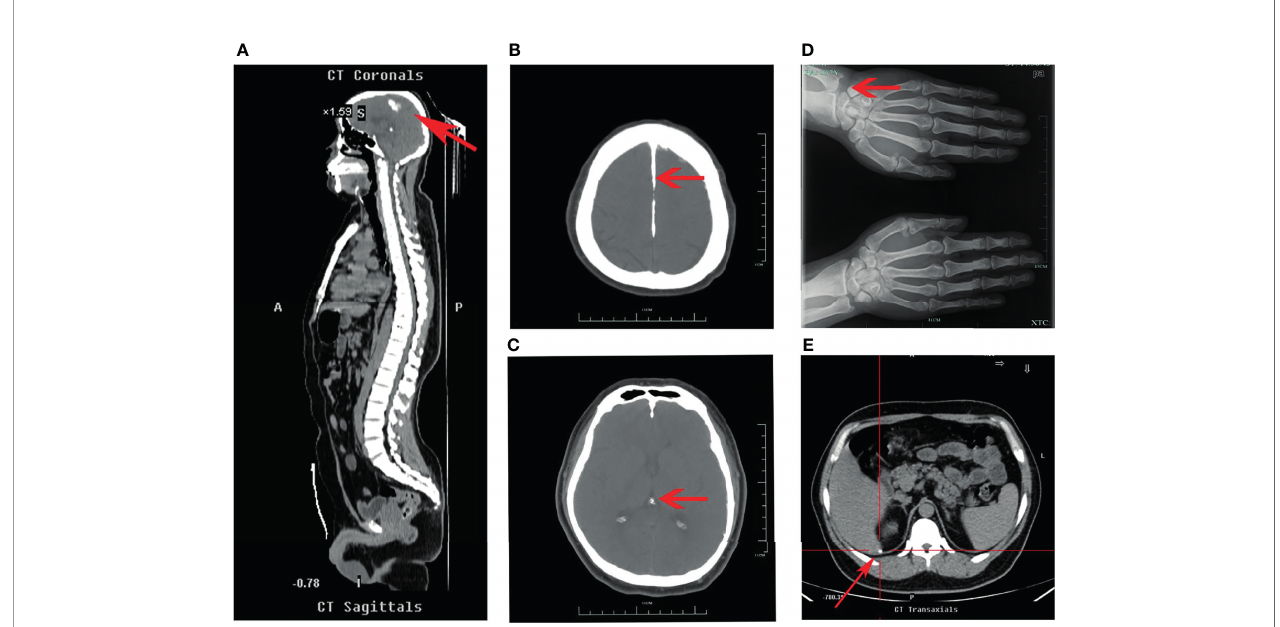
FIGURE 1 | Upper half of body CT, head CT, and X-ray images of the both hands of the patient. (A, B) Upper half of body CT and head CT scans, respectively. Red arrows both indicate calci fi cation of cerebral falx. (C) Head CT scan. Red arrow indicates calci fi cation of tentorium cerebelli. (D) X-ray of both hands. Red arrow indicates calcium deposition. (E) Abdominal CT scan. Red arrow indicates calci fi cation in the subcapsular region of the posterior segment of the right liver